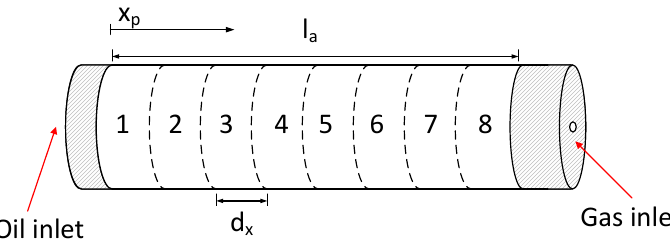
Figure 3. Accumulator wall schematic divided into eight elements including the piston position notation.